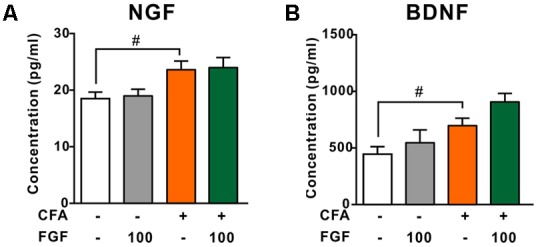
The effect of FGF on spinal NGF and BDNF levels post-CFA injection. The levels of NGF (A) or BDNF (B) in the lumbar spinal cord were examined by ELISA. # vs. controls and ∗ vs. CFA-treated animals. One symbol, p < 0.05; one-way ANOVA and Bonferroni multiple comparison tests as post hoc analyses were used (n = 7–9 mice per group).